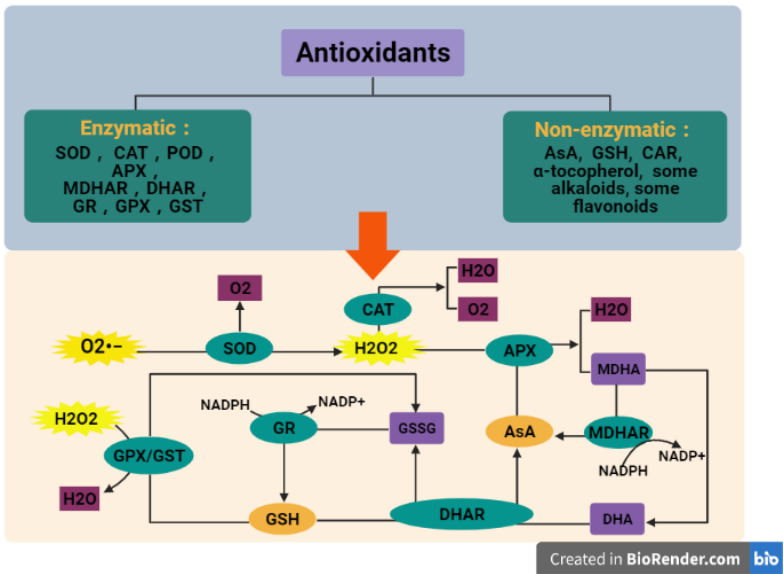
Figure 3. Antioxidant defense mechanisms. Additional details are in the